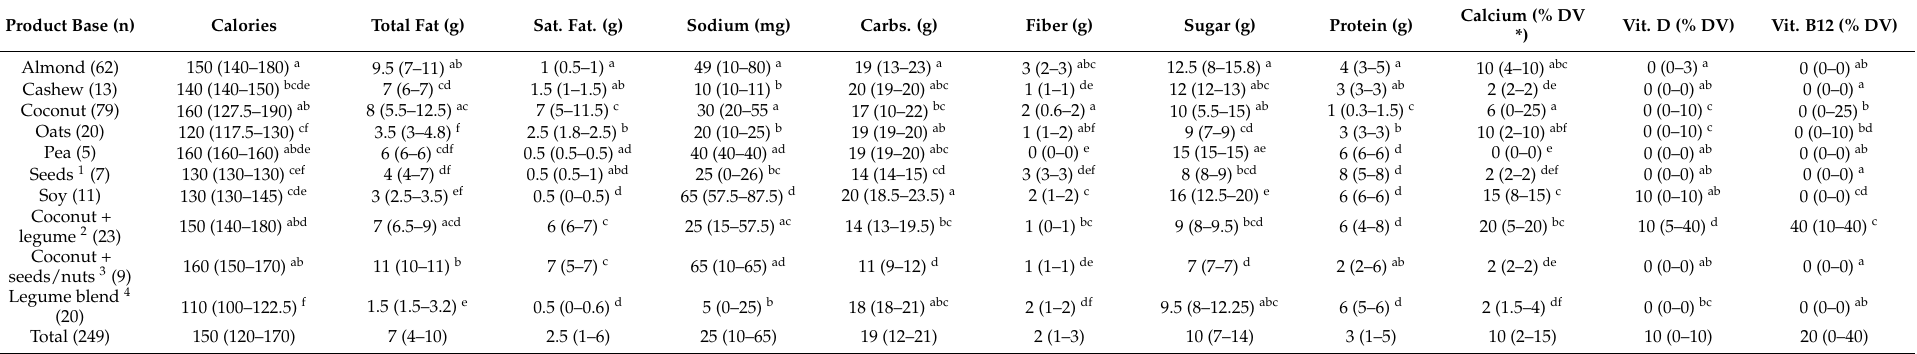
Table 1. The median (Q1–Q3) values of calories and 10 nutrients of non-dairy yogurts/serving classified according to their bases.